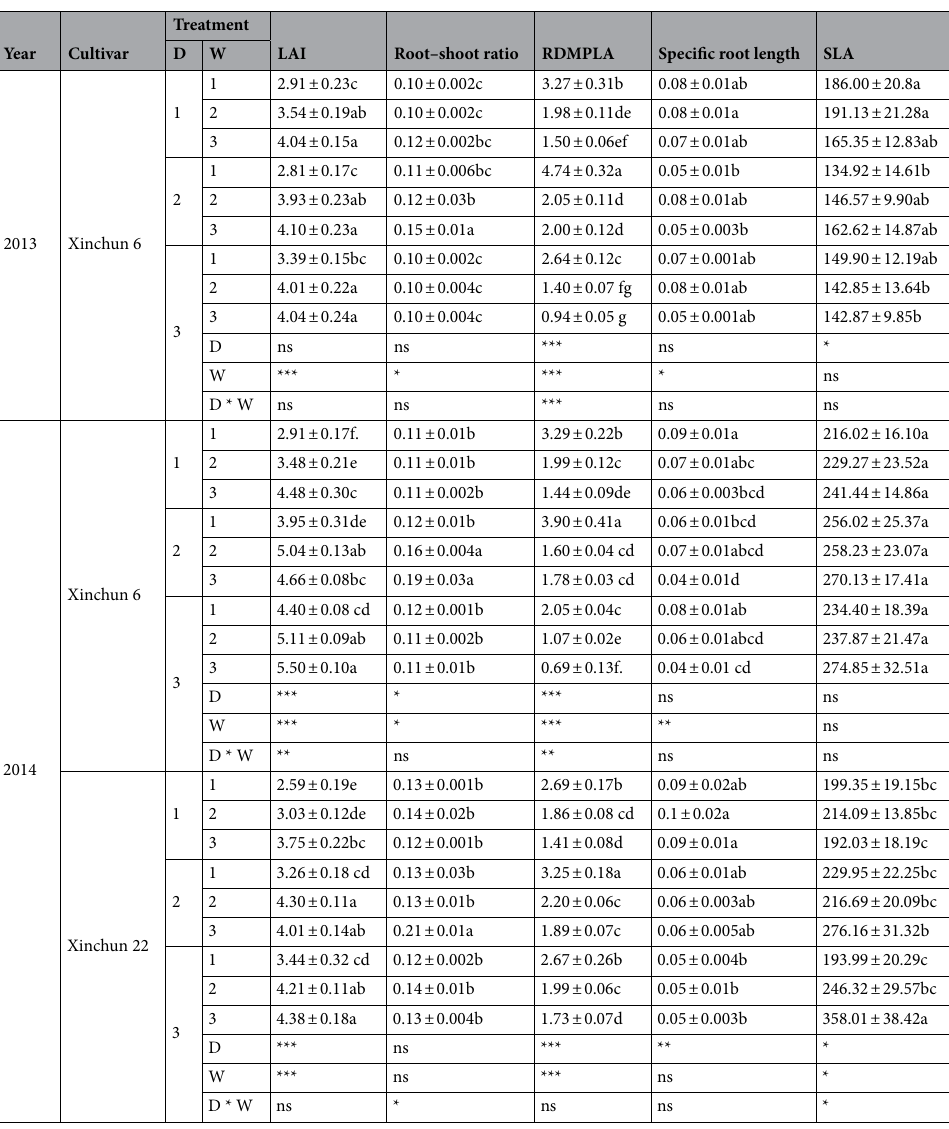
Table 3. Shoot and root characteristics at flowering as affected by drip irrigation frequency and amount. Abbreviations: LAI leaf area index, RDMPLA root dry weight per unit leaf area, SLA specific leaf area, ns represents no significance at the 0.05 probability level. *Represents significance at the 0.05 probability level. **Represents significance at the 0.01 probability